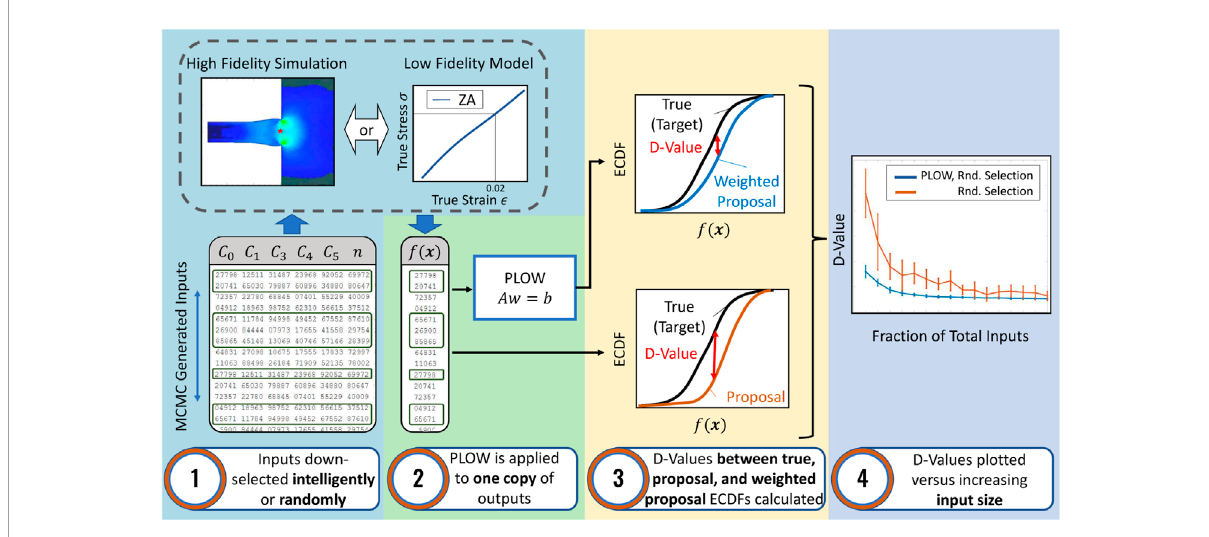
FIGURE 1 Process used to analyze the effect of the PLOW method on the high fidelity Taylor-Anvil simulation and at scale using the Zerilli-Armstrong model. In step 1, a distribution of possible parameter values is generated and down-selected. In step 2, PLOW is applied to one copy of outputs obtained by propagating the down-selected inputs. The term f ( x ) in step 2 represents the output from the simulation or model evaluations. In step 3 the full output distribution, non-weighted, down-selected distribution, and the PLOW weighted, down-selected distribution are compared. Here, f ( x ) is the random variable on the axis of abscissas. The D-value, or distance value, is the metric used to determine how similar two empirical distributions are. In step 4, the D-values are plotted as a function of the number of down-selected inputs in step 1.